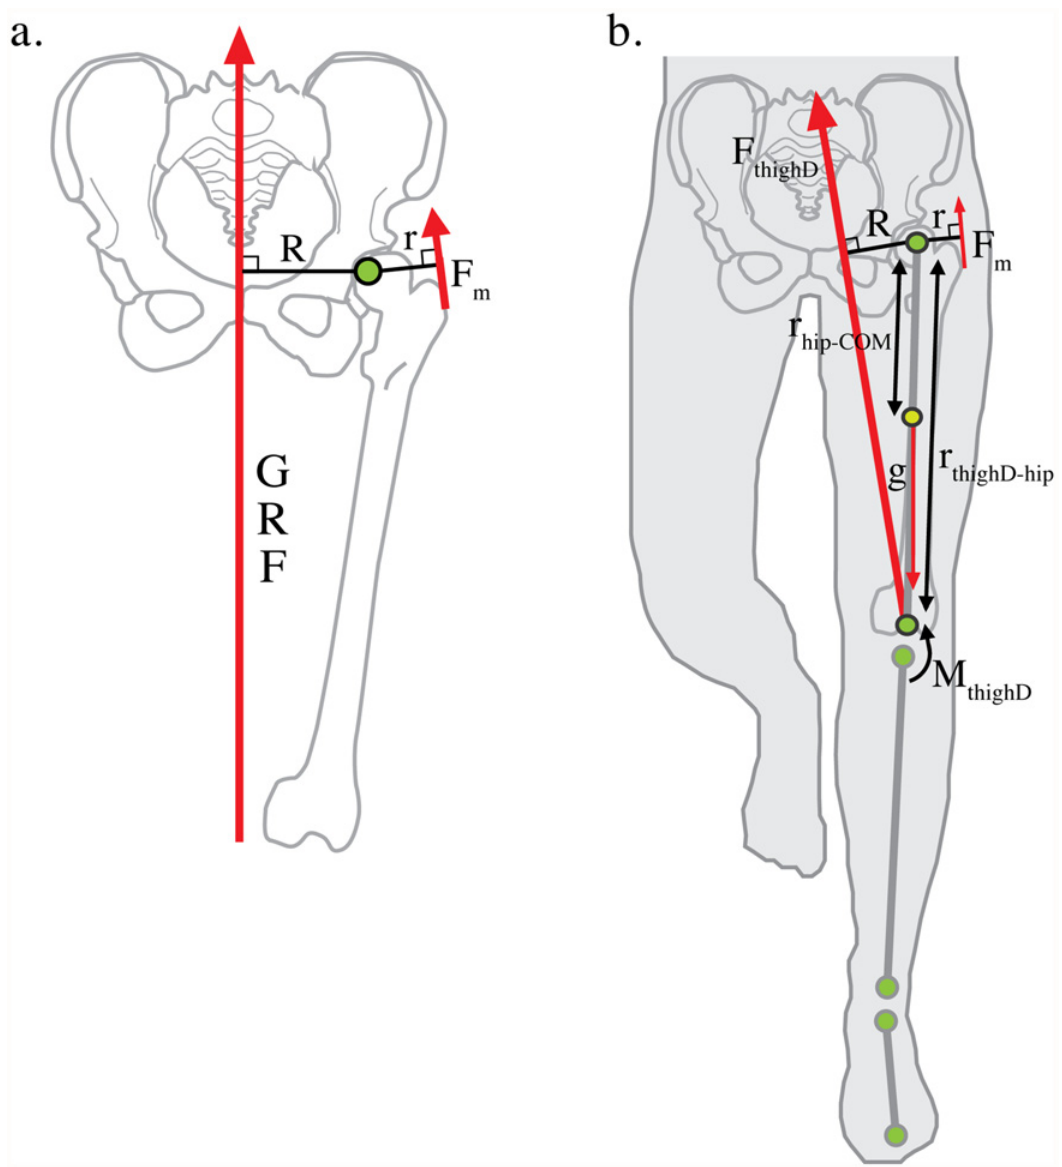
Fig 1. Static and dynamic models of hip abductor force production. a. The standard static biomechanical model of hip abductor force production assumes the ground reaction force vector ( GRF ) passes nearly vertically through the body center of mass during locomotion. The effective mechanical advantage ( EMA ) of the hip abductor muscles is defined as r / R , where r is the abductor muscle moment arm and R is the moment arm of the GRF vector. Hip abductor force ( F m ) is equal the multiple of GRF and 1/ EMA . A narrow pelvis is thought to reduce locomotor cost by decreasing R and hip abductor force production, but this may increase the likelihood of cephalopelvic disproportion (CPD) by narrowing the maternal birth canal. b. Inverse dynamics models the lower extremity as a series of linked-segments in which the foot, shank and thigh each act as rigid bodies interacting at frictionless joints [23,24]. The net internal hip moment is equal to the thigh moment of inertia times its angular acceleration, minus the distal thigh moment ( M thighD ), minus the cross-product of the positional vector of hip relative to the thigh center of mass ( r hip-COM ) and gravity ( g ), minus the external moment acting on the thigh defined as the cross product of the positional vector of the distal thigh segment relative to the hip ( r thighD-hip ) and the force vector acting on the distal thigh ( F thighD ). R can then be measured dynamically as the perpendicular distance from the hip joint center to F thighD (see Methods). If the predictions of the static model and the obstetrical dilemma hold, R measured dynamically will be nearly equal to half- biacetabular width.